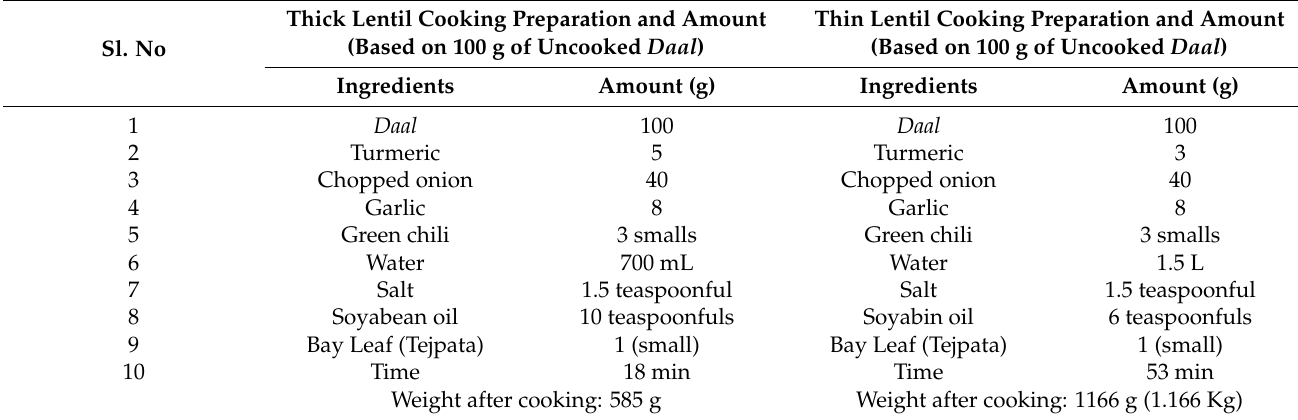
Table 1. Recipes of thick and thin preparations of iron-fortified